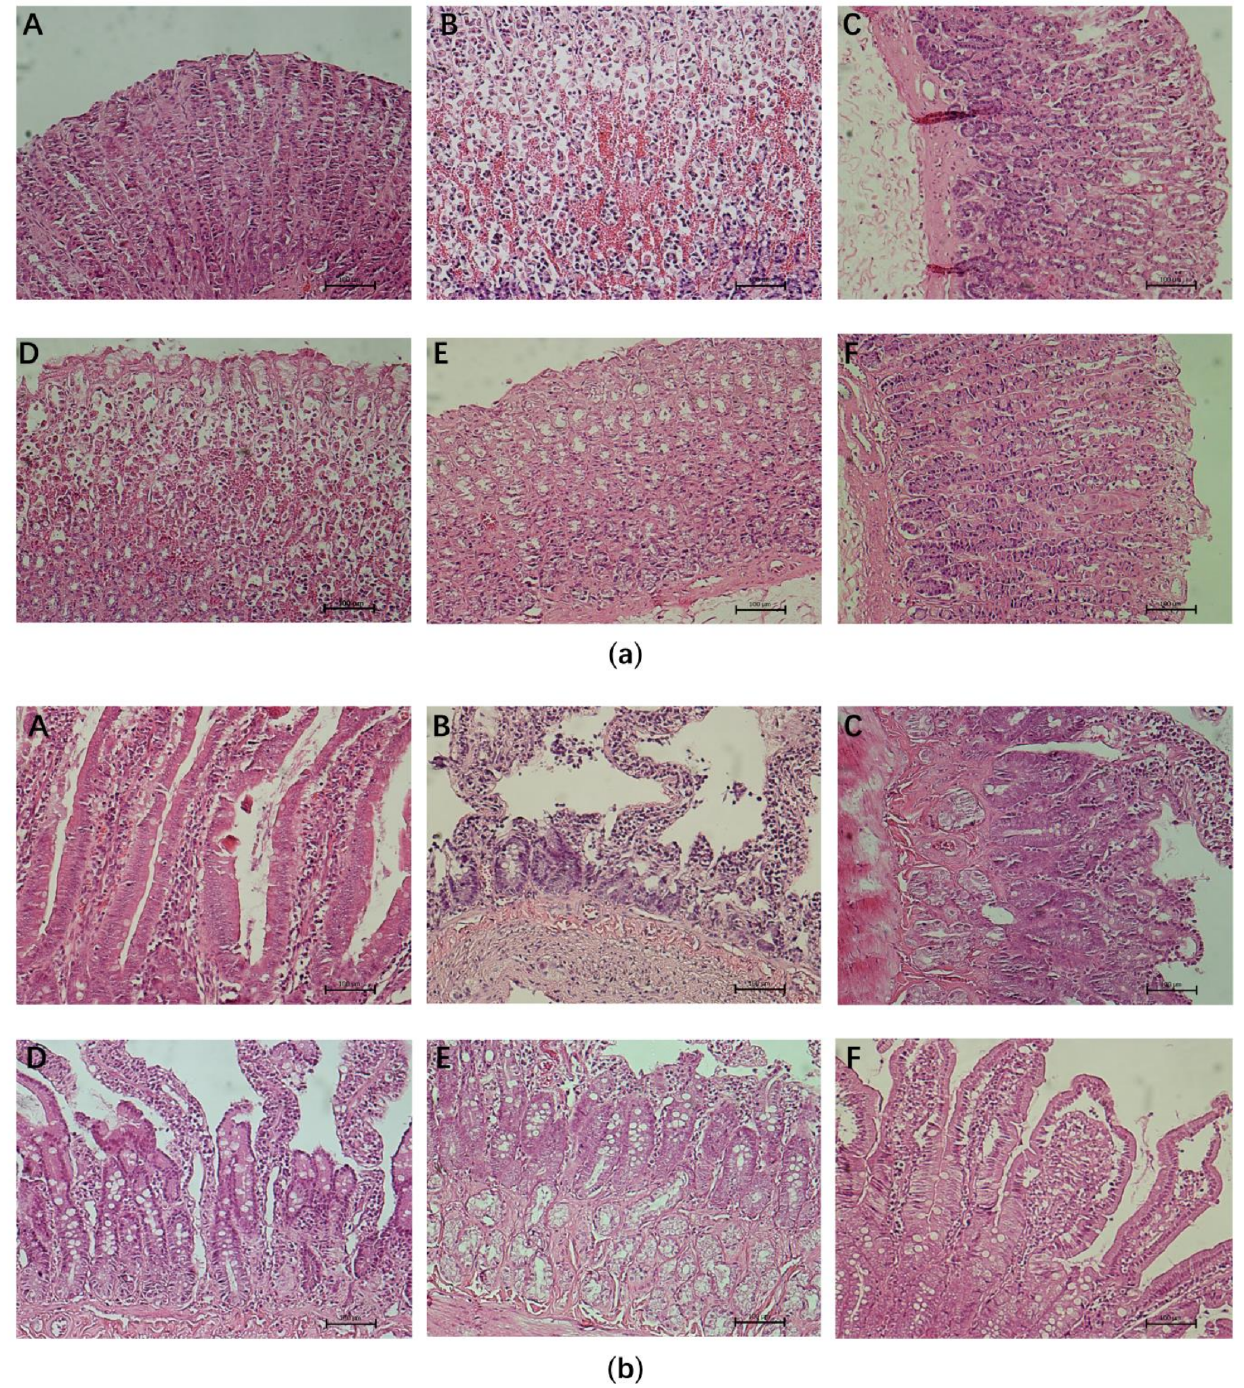
Figure 2. Effect of tilapia collagen oligopeptides (TCOPs) on gastric ( a ) and duodenal ( b ) histomorphology in rats. Photomicrographs of HE (magnification 200 × ) stained sections from gastroduodenal mucosa. A : normal control; B : ethanol control; C : whey protein, 250 mg/kg of whey protein; D : 250 mg/kg of TCOPs-L; E : 500 mg/kg of TCOPs-M; F : 1000 mg/kg of